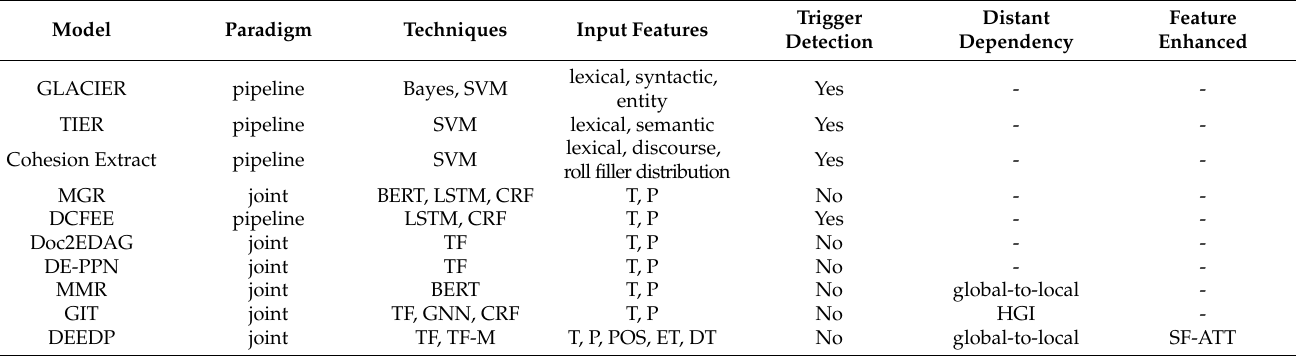
Table 6. Model comparison results. T: Token, P: Position, POS: Part-of-Speech, ET: Entity